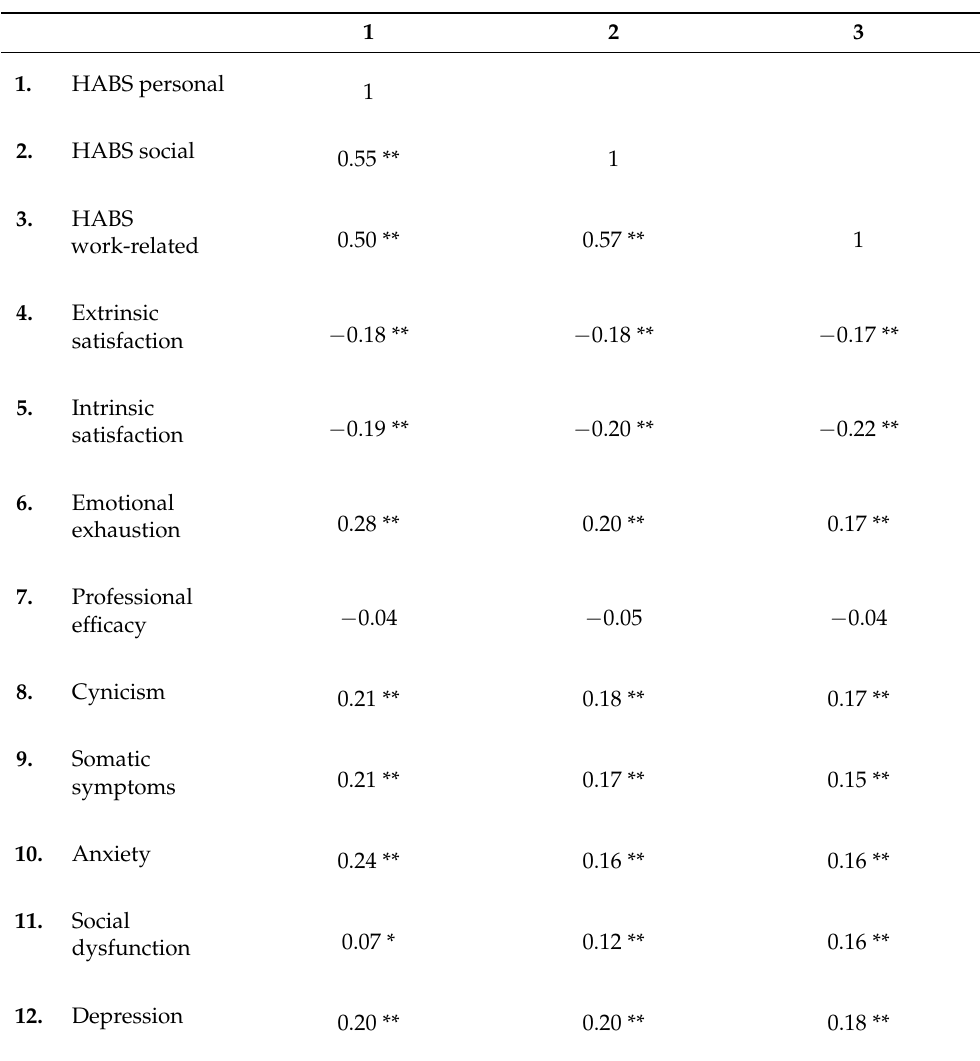
Table 8. Lateral violence